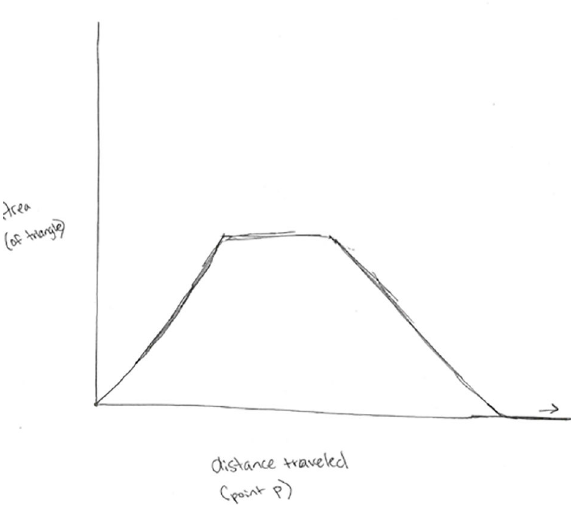
Figure 6. Olivia’s graph comparing the triangle’s area to distance traveled